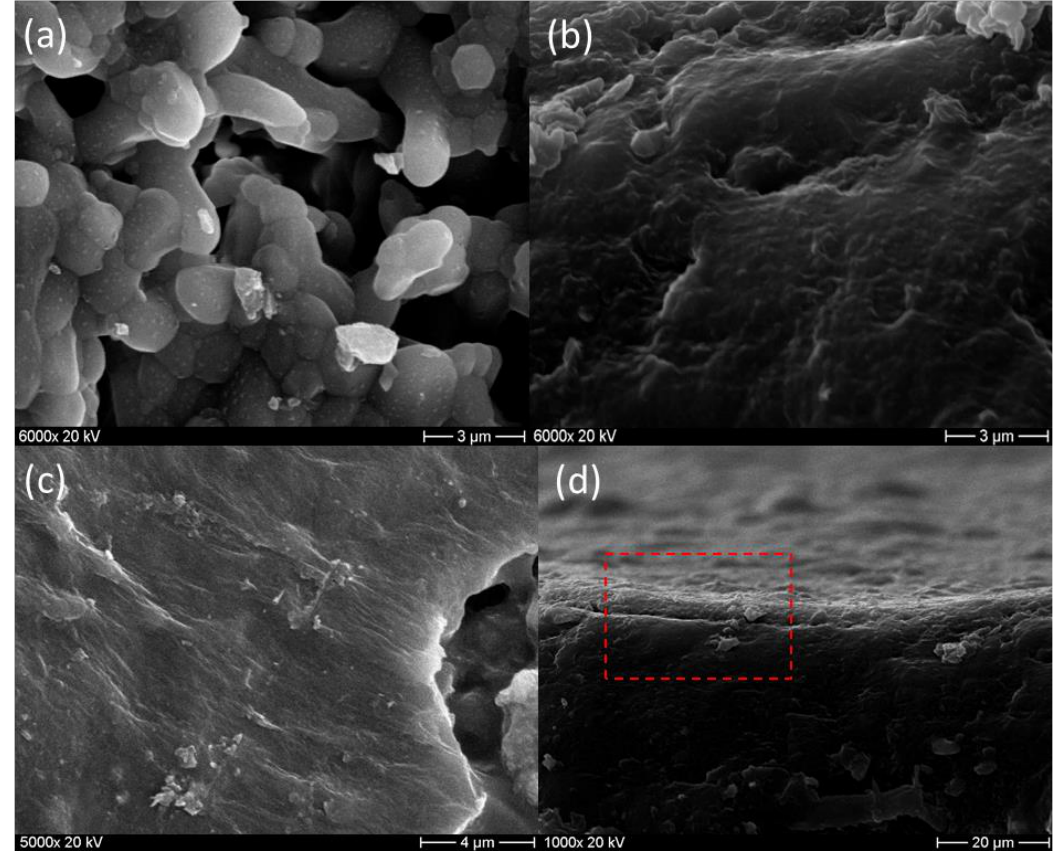
Figure 9. SEM images of ( a ) the phosphate ceramic support before coating with GO, ( b ) the GO/ceramic composite membrane surface after coating, ( c ) the GO layers coated on the membrane surface and ( d ) the cross-section of the GO/ceramic composite membrane.